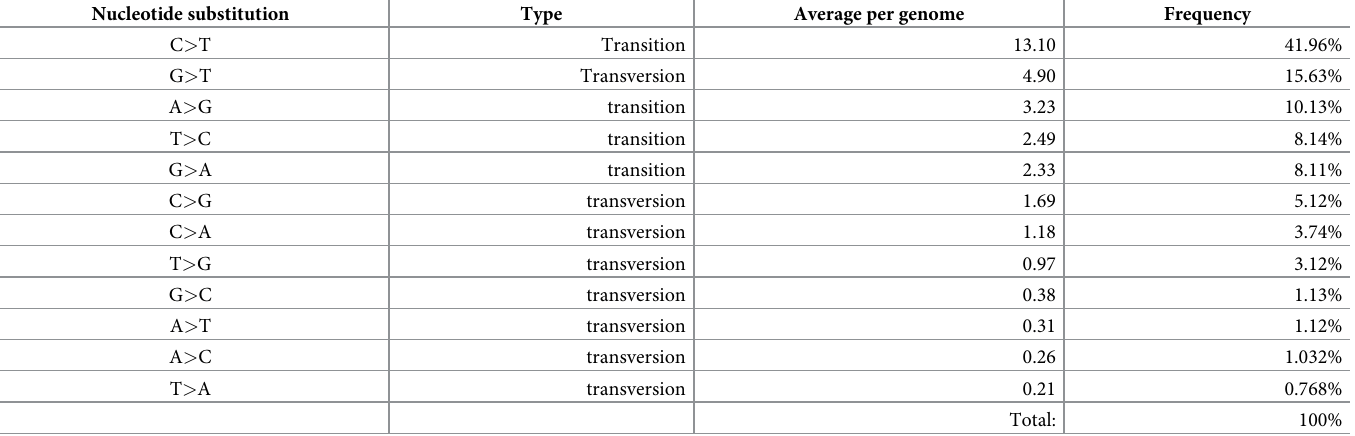
Table 2. Single nucleotide substitutions frequency in the genome of SARS-CoV-2 isolates (n = 39) from Uzbekistan. Nucleotide substitution Type Average per genome Frequency C > T